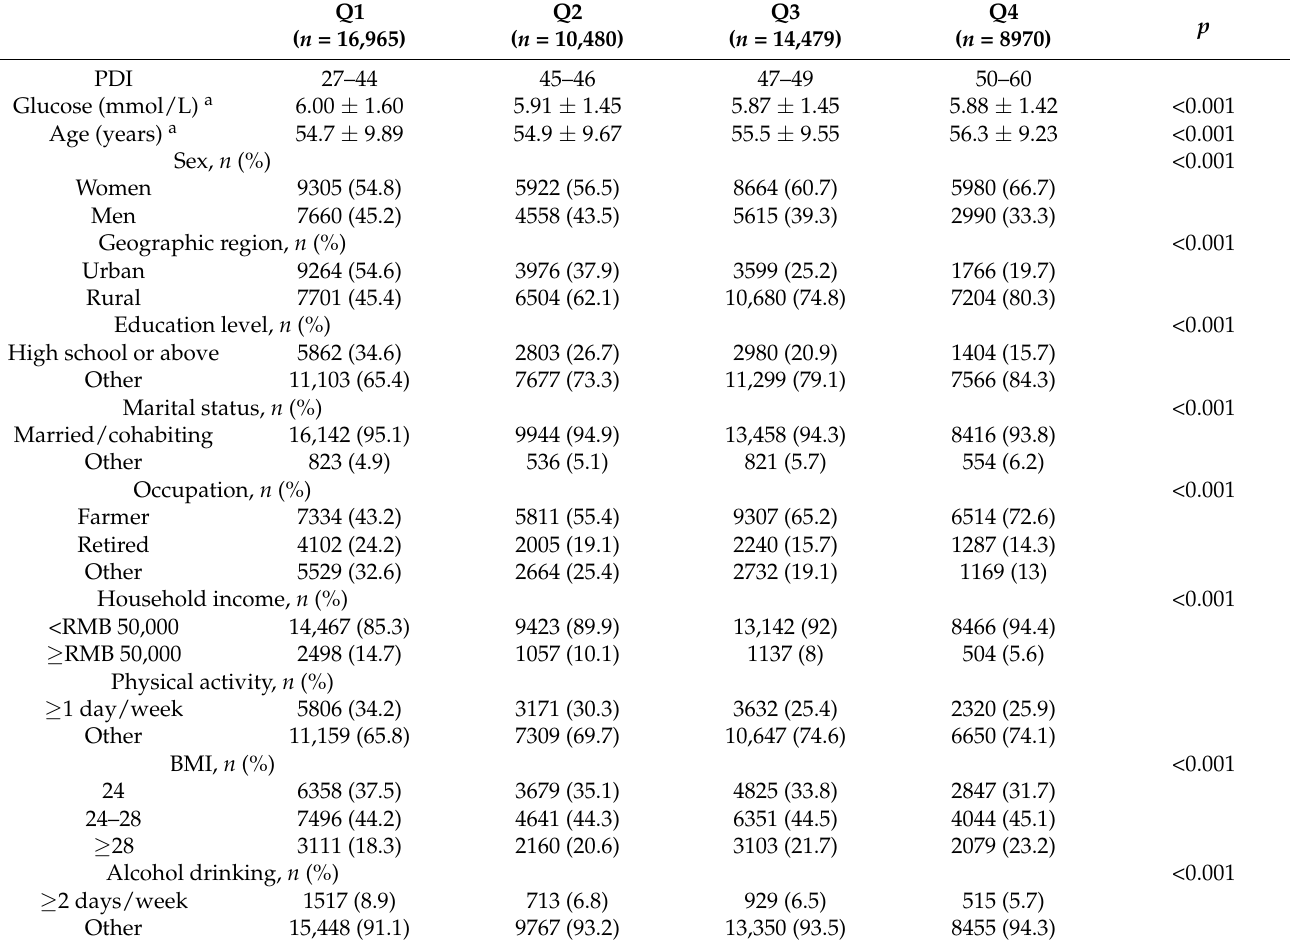
Table 1. Characteristics of participants grouped by quartiles of plant-based diet